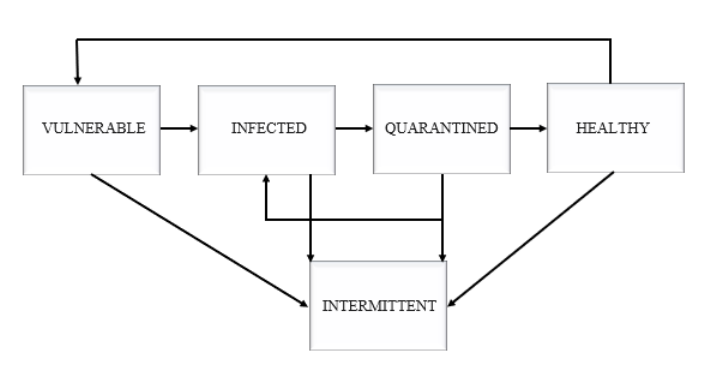
Figure 6. Diagram of the state transitions.